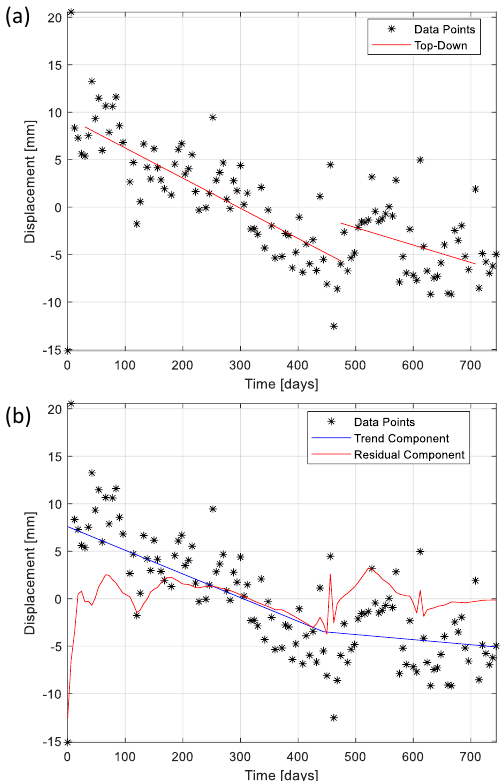
Figure 9. Displacement time series of PS 3 (a) divided into two segments, (b) approximated by a piecewise linear model.